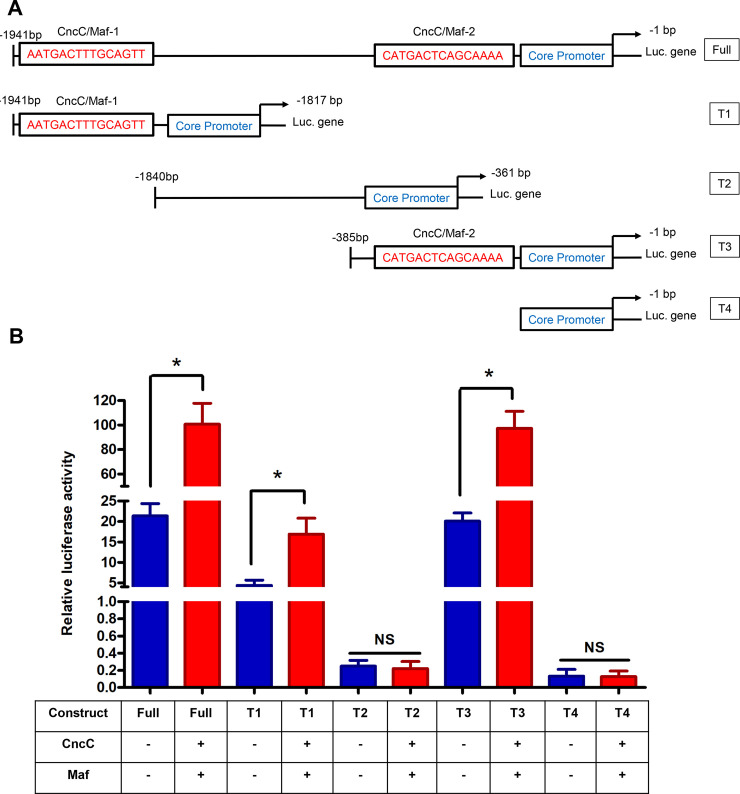
CncC and Maf regulate the expression of CYP321A8 by binding to proximal and/or distal sites.(A) Schematic representation of the CYP321A8 promoter deletions. (B) Analysis of the activity of CYP321A8 promoter deletions in reporter gene assays in the presence and absence of CncC/Maf. The luciferase activity was normalized with the Renilla luciferase activity. Error bars display SD. The full-length promoter and each truncated version were compared using Student’s t-test. Significant differences (p < 0.05) in the luciferase activity are indicated using an asterisk.